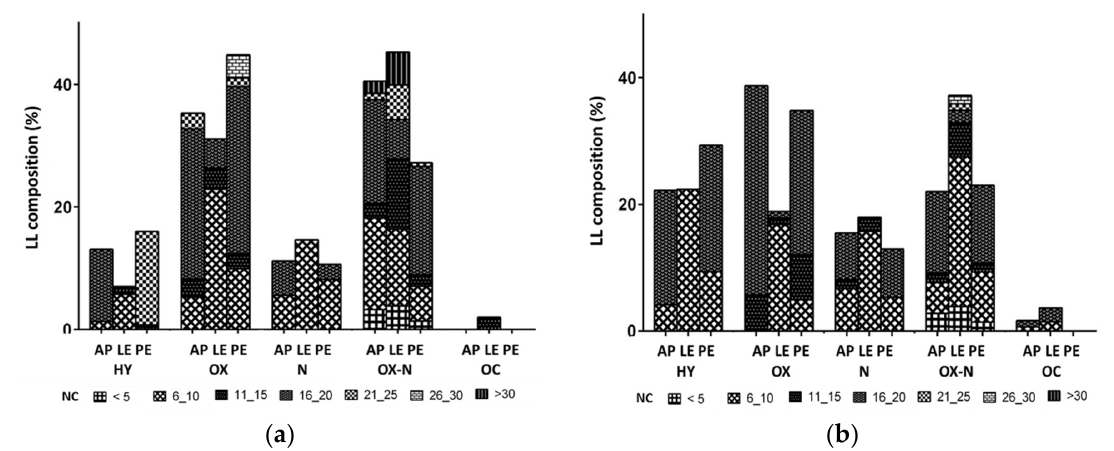
Figure 6. Composition of light reaction liquids (LL), determined by GC–MS, resulting from catalytic pyrolysis of Arthrospira platensis biomass without any treatment (AP), after lipid extraction (LE), and after protein extraction (PE). HY, hydrocarbons; OX, oxygenates; N, nitrogenates; OX–N, complex oxygenates / nitrogenates; OC, other compounds; NC, number of carbons. Catalyst: ( a ) ZSM5, ( b ) silica–alumina. Table 3. Percentage composition (%) of light reaction liquids (LLs) from catalytic pyrolysis using ZSM5 or silica–alumina as catalyst in terms of individual compounds. Analytical determinations were made by GC–MS on LLs from untreated Arthrospira platensis biomass (AP), biomass after lipid extraction (LE), biomass after protein extraction (PE).